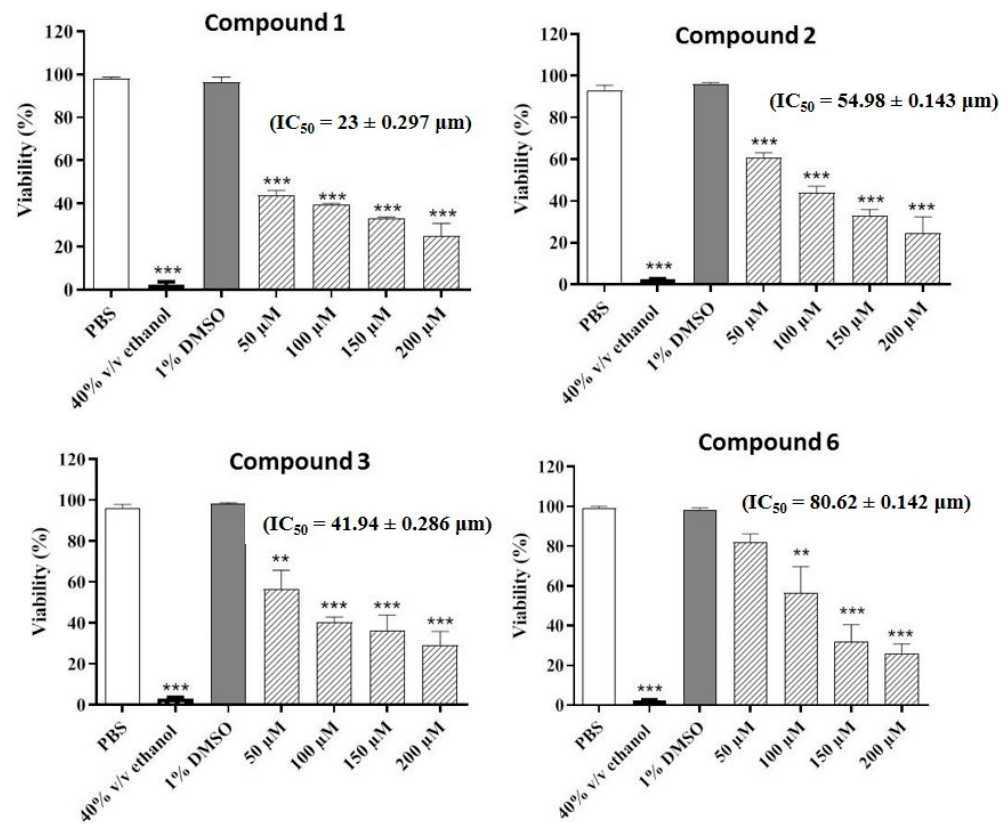
Figure 2. Concentration-dependent increase in nematicidal activities of the most active compounds. Phosphate buffered saline (PBS) and ethanol (70% v/v ) were employed as negative and positive controls, respectively. Values represent mean ± S.D. *** p < 0.001 and ** p < 0.01.